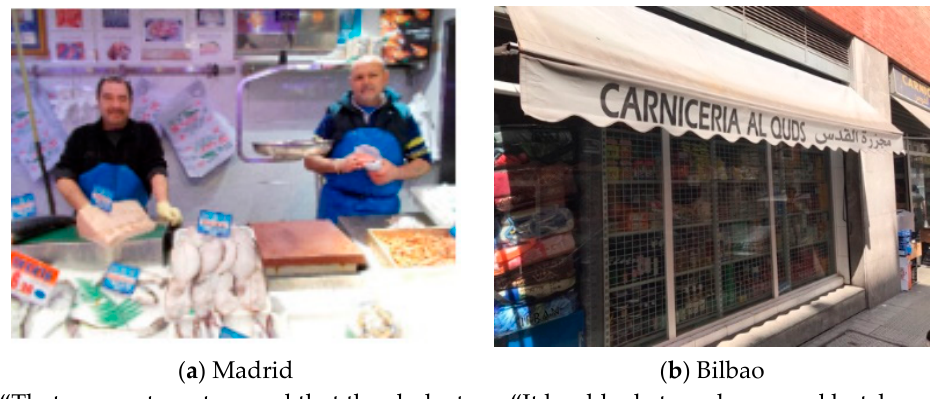
Figure 5. ( a ) Photograph made in Madrid: “The fishermen”. Category: Personal treatment. Theme: The neighborhood store; ( b ) Photograph made in Bilbao: “Butcher with blankets”. Category: Product overcrowding. Theme: Market transformation.